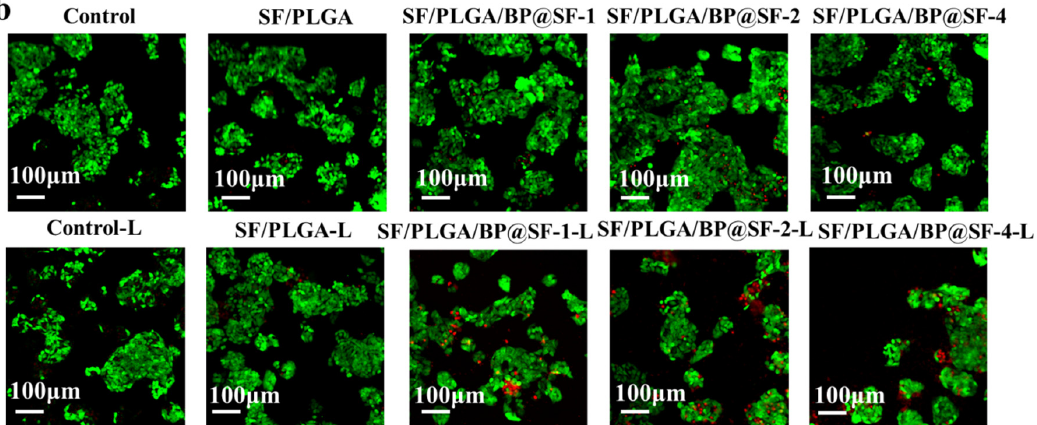
Figure 6. In vitro anti-tumor properties of the electrospun membranes. ( a ) Evaluation of cell viability by CCK-8 assay; ( b ) LIVE/DEAD cell staining of HepG2 cells on the second day of culturing. *P < 0.05, **P < 0.01, ***P < 0.001, data represent means ± SD.